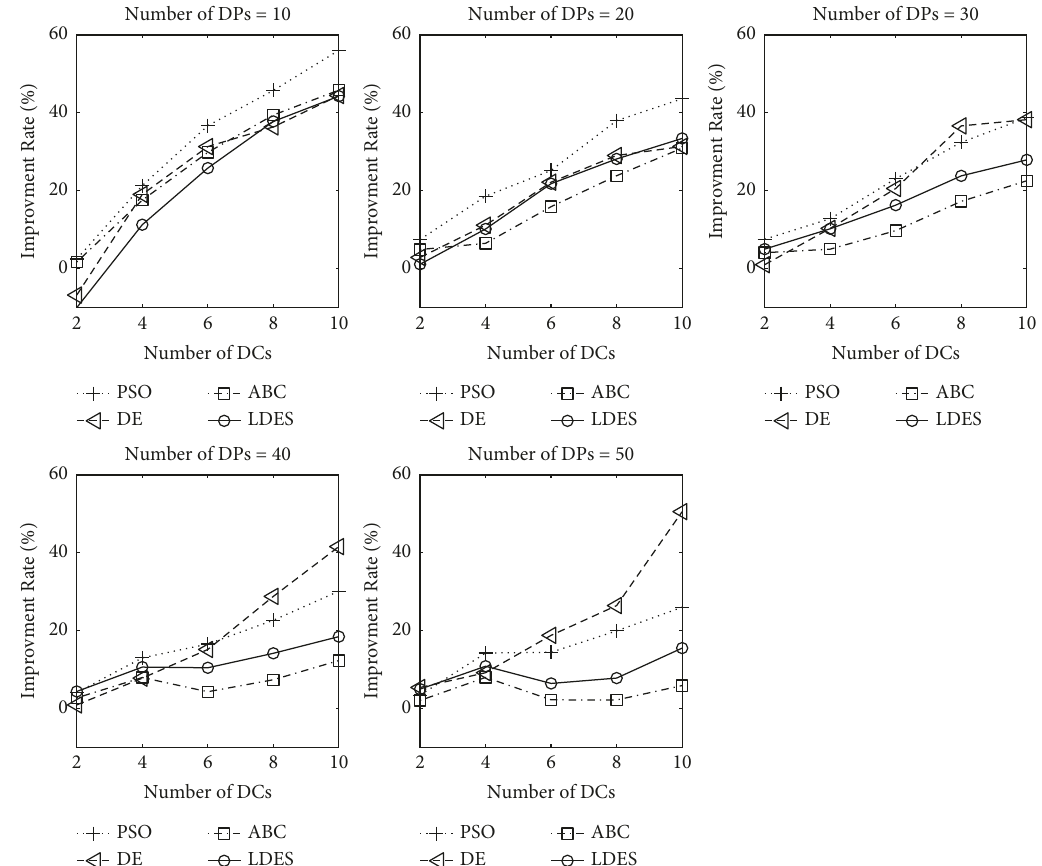
Figure 10: Improvement of RPK over TES when the number of DPs